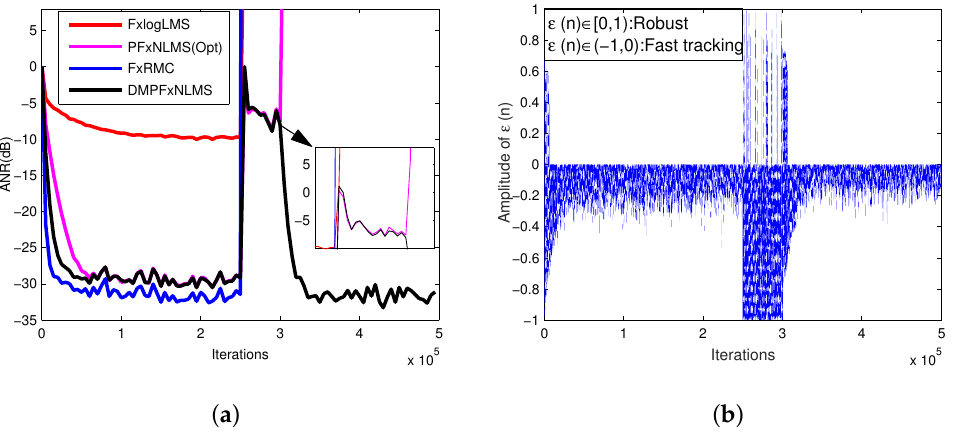
Figure 5. Performance comparison when impulsive interference α = 1.2 ( a ) ANR curves; ( b ) changing process of ε ( n ) .